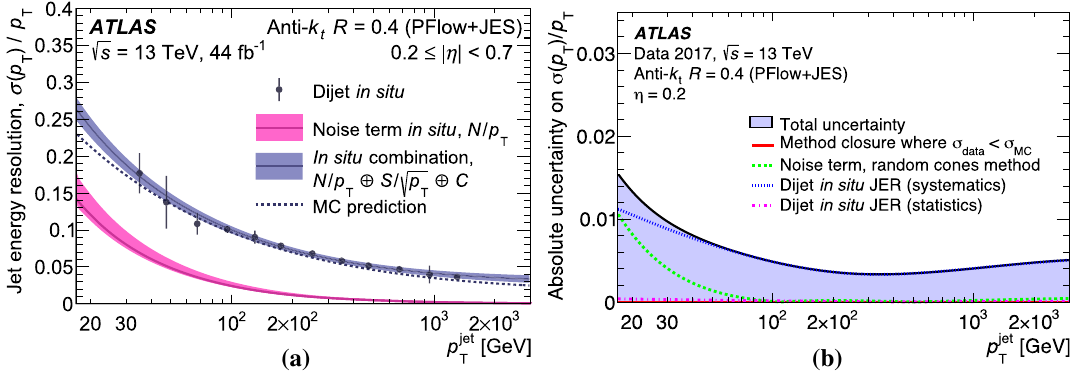
Fig. 29 a Therelativejetenergyresolutionasafunctionof p T forfully calibrated PFlow+JES jets. The error bars on points indicate the total uncertainties on the derivation of the relative resolution in dijet events, adding in quadrature statistical and systematic components. The expec- tation from Monte Carlo simulation is compared with the relative reso-